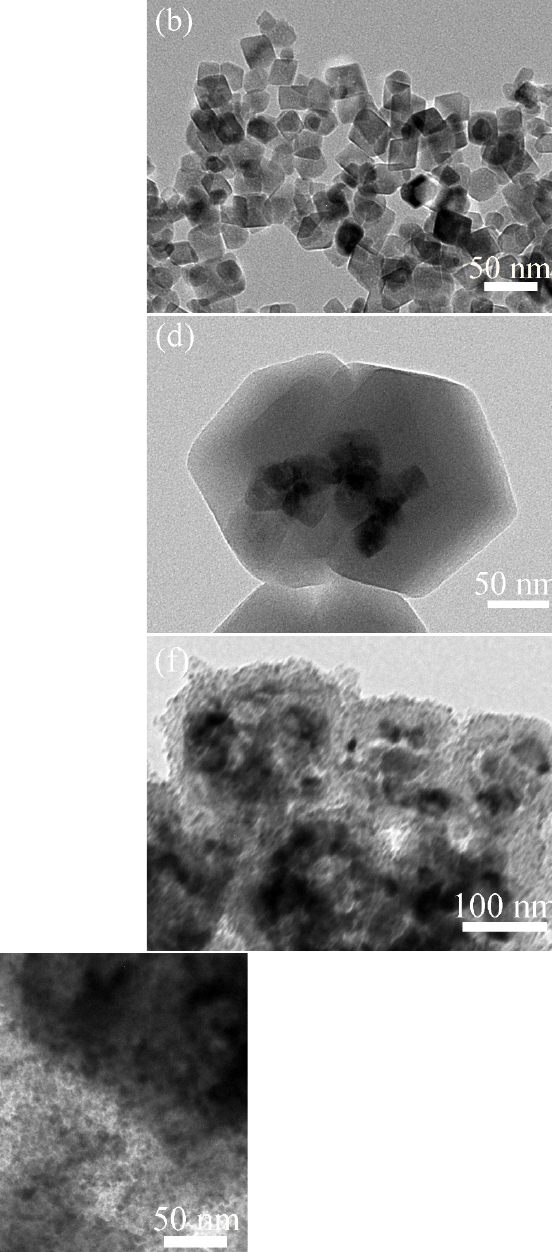
Figure 2. ( a ) SEM and ( b ) TEM images of MnCO 3 nanopolyhedrons; ( c ) SEM and ( d ) TEM images of MnCO 3 @ZIF-67; and ( e ) SEM, ( f ) TEM and ( g ) local TEM images of MnS@CoS/C. MnCO 3 @ZIF-67; and ( e ) SEM, ( f ) TEM and ( g ) local TEM images of